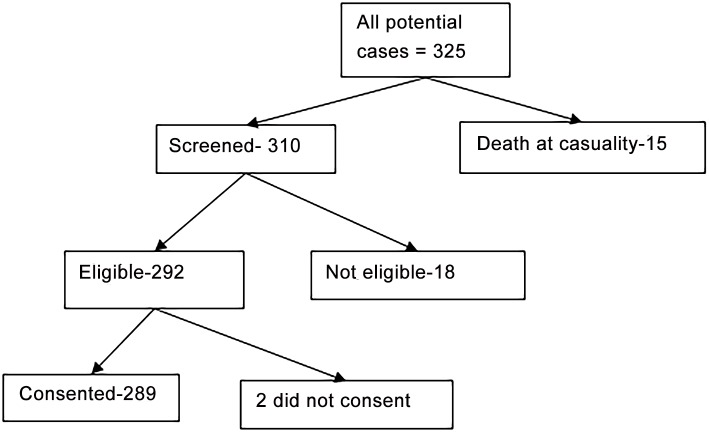
The first table shows the background characteristics of the cases and controls and tests the significance of the difference between the two groups.The second table focuses on risky practices and related un-adjusted odds ratios for getting a motor-cycle injury. The rest of the tables have results from multivariable analysis.